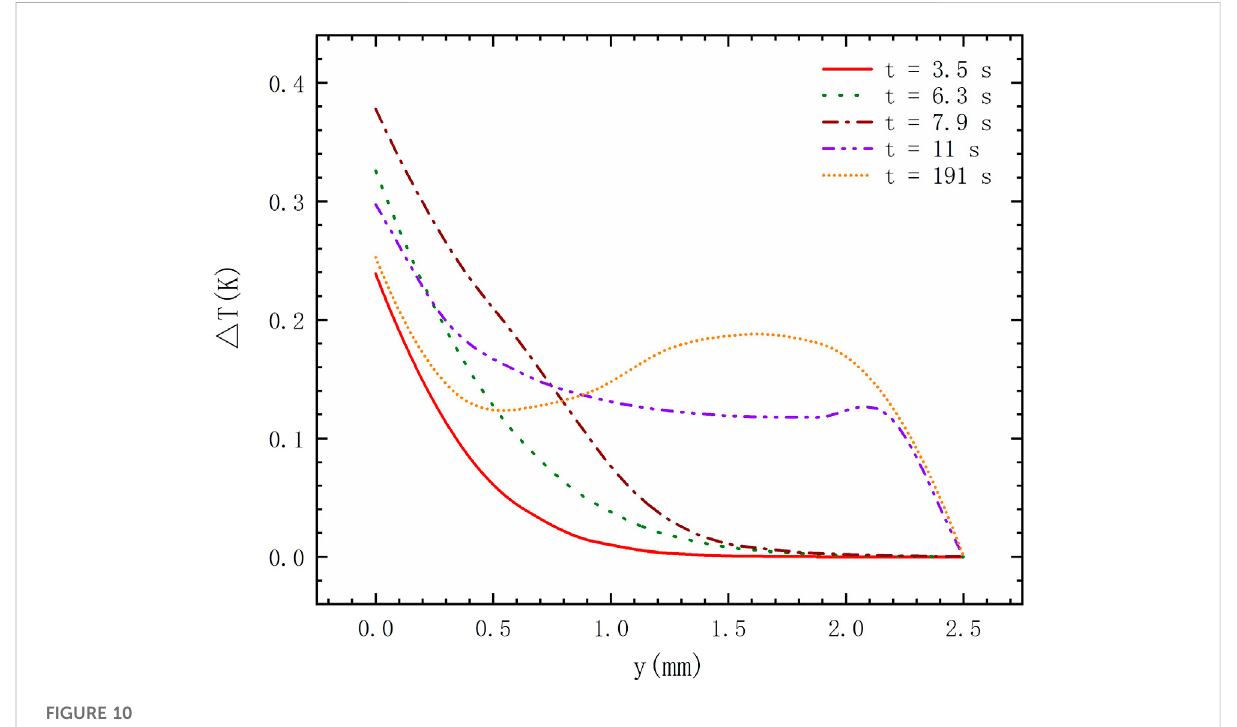
FIGURE 10 Temperature distributions along the line x = 5